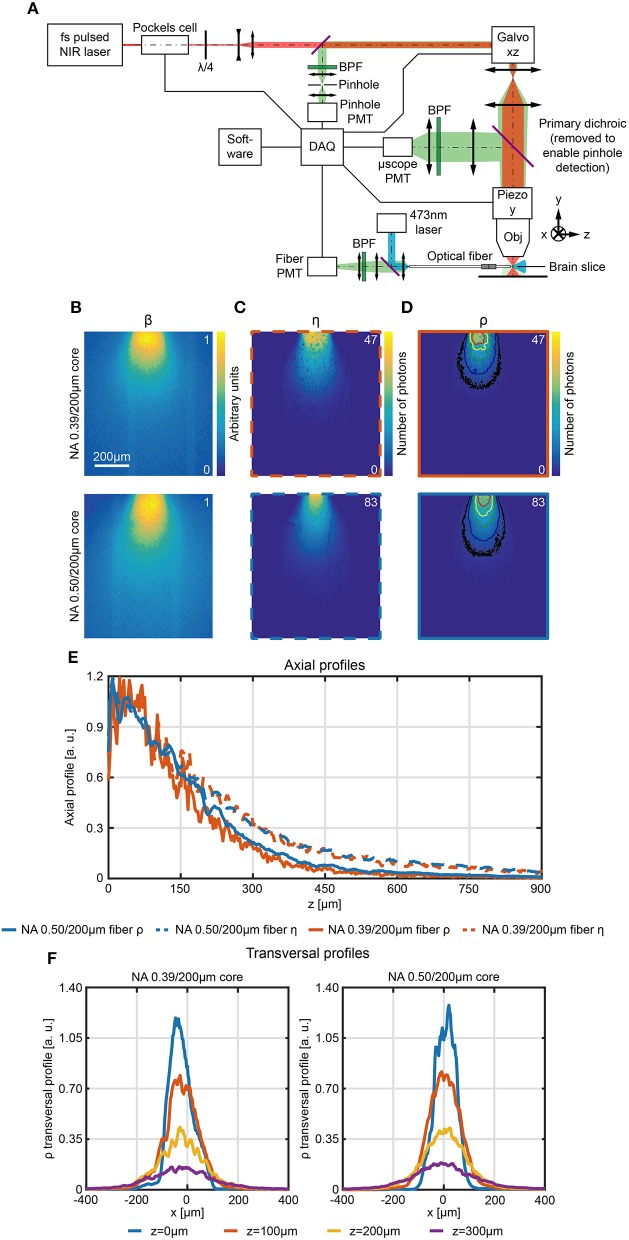
Scanning pinhole detection of the excitation light field for fiber optics. (A) Schematic representation of the optical path used to measure the photometry efficiency diagram of optical fibers in fluorescently stained brain slices. (B–D) Section y = 0 of the normalized light emission diagram β (B), the collection efficiency η (C) and the photometry efficiency ρ (D) of 0.39/200 μm and 0.50/200 μm optical fibers, as indicated, measured in a 300 μm thick fluorescently stained brain slice. In (D) isolines at 10%, 20%, 40%, 60%, and 80% of the maximum efficiency are shown (in black, blue, green, yellow, and red, respectively). (E) Comparison of normalized axial profiles (x = 0, y = 0) between 0.39/200 μm and 0.50/200 μm fibers for photometry efficiency (orange and blue continuous curve, respectively) and collection efficiency (orange and blue dashed curve, respectively). Normalization is done with respect to the average of the points within the firsts 80 μm. (F) Normalized photometry efficiency transversal profiles at different depths (z = 0 μm, 100 μm, 200 μm, 300 μm, y = 0) for 0.39NA/200 μm and 0.50NA/200 μm fibers (left and right panel, respectively).